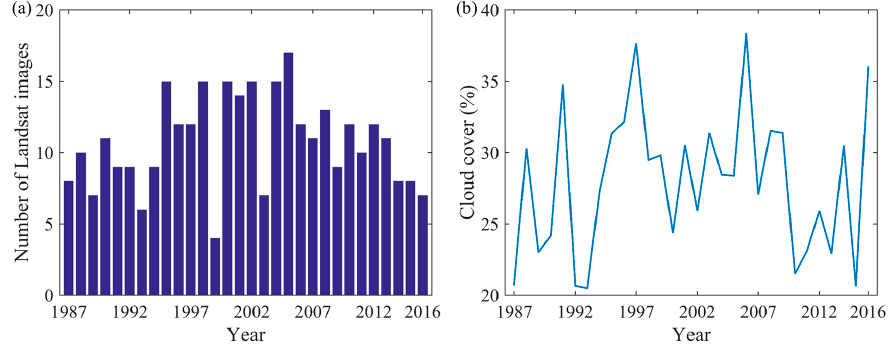
Figure 1. Geographical location of Changxing Island and Hengsha Island, Shanghai,